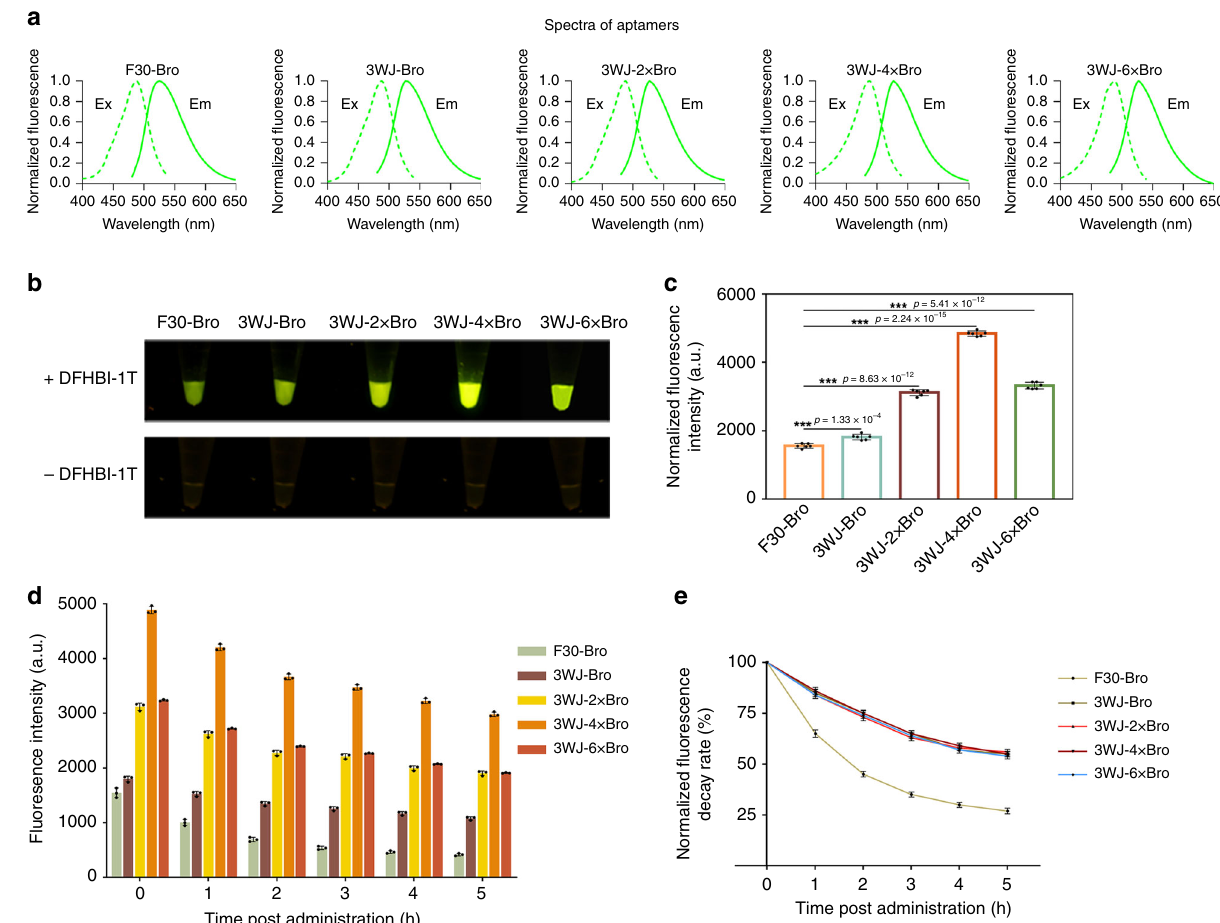
Fig. 1 In vitro performance of the 3WJ-nBro series. a Excitation (dashed) and emission (solid) spectra of RNA aptamers. b Representative fl uorescence images of 3WJ-nBro series from a Blue Light Gel Imager (three replicated trials). c Fluorescence quanti fi cation of 3WJ-nBro series. Error bars depict the mean ± standard deviation (s.d.) ( n = 6) and p values are calculated using an unpaired, two-tailed, Student ’ s t test. *** p < 0.001. d Fluorescence detection within 5 h after DFHBI-1T administration ( n = 3). e Normalized fl uorescence decay rate calculated as the ratio of remaining fl uorescence to initial fl uorescence ( n = 3). All experiments above were repeated three independent times. Source Data are provided as a Source Data fi le. fl uorescence intensity for 3WJ-Bro compared with F30-Bro, Table 1 The spectral characteristics of fl uorescent RNA indicating that our 3WJ scaffold improved the fl uorescence aptamers. intensity of Broccoli (Fig. 1c). Furthermore, the fl uorescence intensities of 3WJ-2 × Bro and 3WJ-4 × Bro were 0.5-fold and 1.2-fold higher, respectively, than that of 3WJ-Bro, whereas that of 3WJ-6 × Bro was lower than that of 3WJ-4 × Bro but 0.7-fold repeated Broccoli units in the 3WJ scaffold and linker did pro-